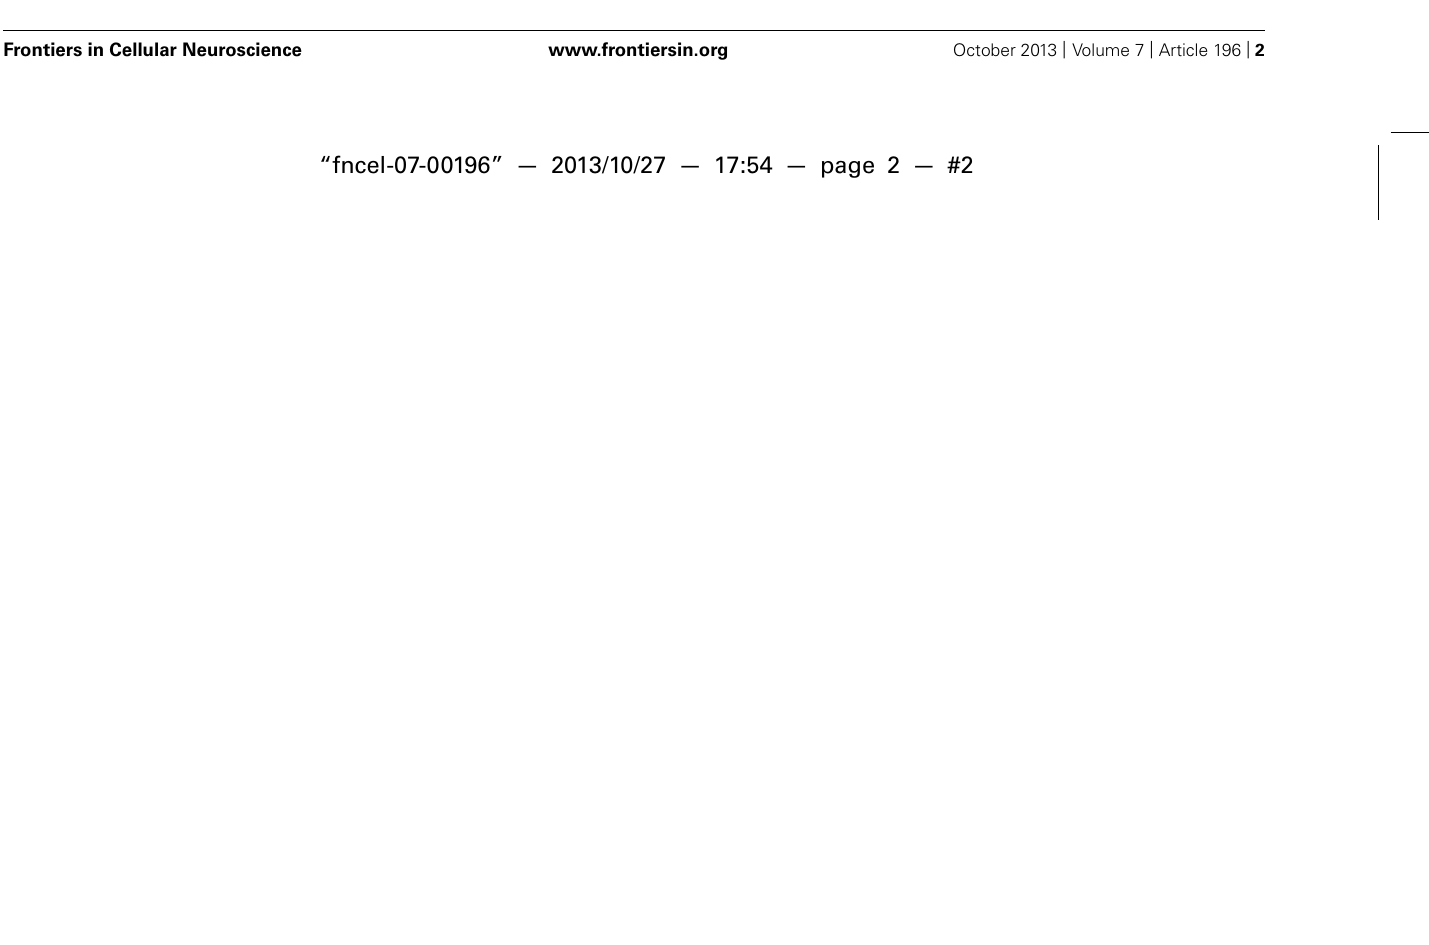
These molecules bind NF186, NrCAM, and Contactin-1 which are expressed at CNS nodes. (C) The complex Contactin-1/Caspr-1/NF155 forms the septate-like junctions at both PNS and CNS paranodes.This complex is stabilized by the cytosolic protein 4.1B which co-localizes with ankyrin-B, α II- and β II-spectrin at both paranodes and juxtaparanodes. (D) The complex Contactin-2/Caspr-2 enables the sequestration of Kv1.1/Kv1.2/Kv1.6 channels at juxtaparanodes, but also of PSD-93 and PSD-95. ADAM22 and Connexin-29 (Cx29) are also enriched at